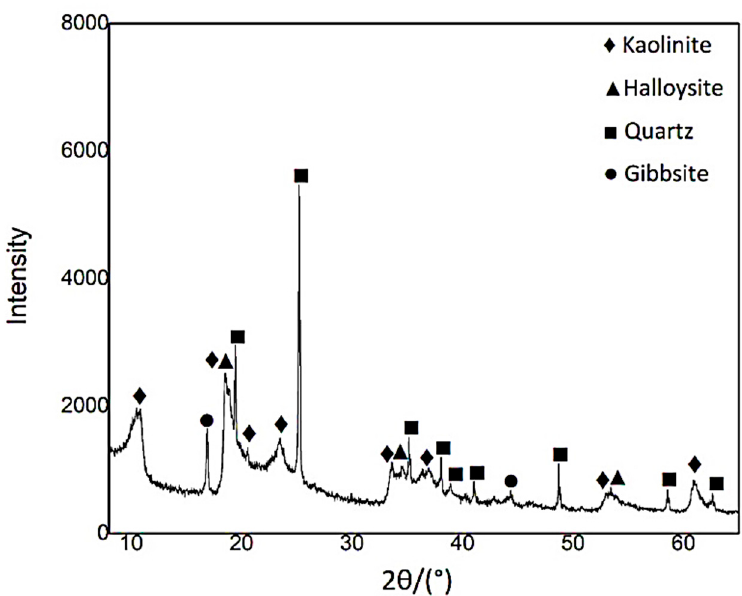
Figure 2. XRD pattern of aluminous clay.